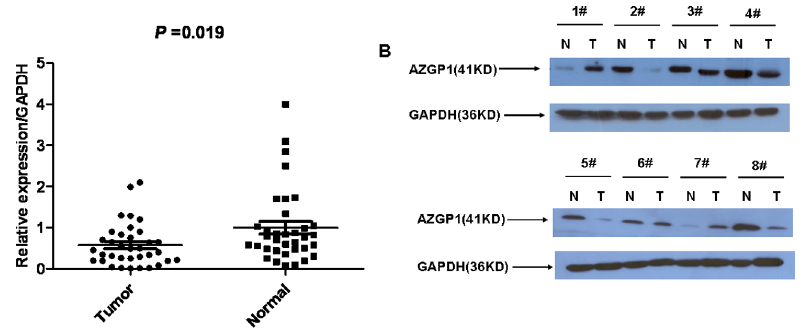
Figure 2. Western blotting analysis of AZGP1 expression in gastric cancer patients. (A) The relative AZGP1 protein expression levels was significantly decreased in gastric cancer tissues compared with the matched adjacent non-tumorous tissues (n=35, P =0.019); (B) Representative results of western blotting analysis of AZGP1 protein expression in eight gastric cancer tissues (T) and the matched adjacent non-tumorous tissues (N).